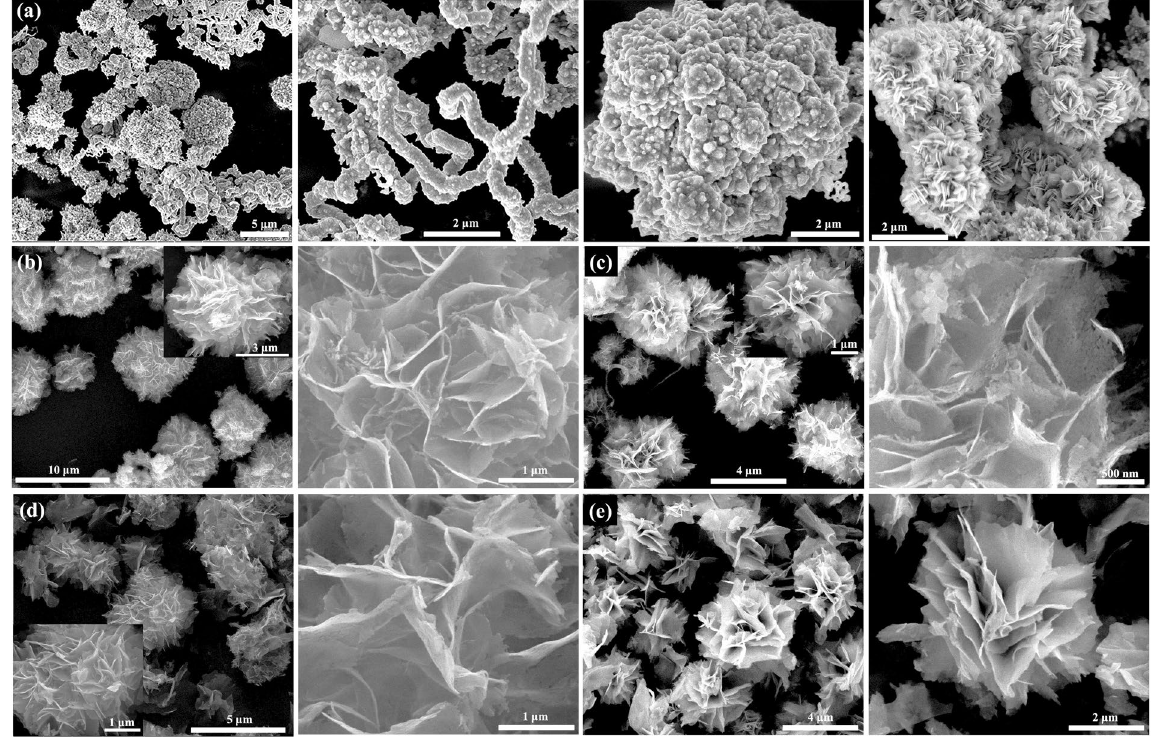
Figure 3. SEM images of as-prepared samples with different amount of Cd contents by keeping all other synthetic conditions fixed: ( a ) Cd-0, ( b ) Cd-0.5, ( c ) Cd-1, ( d ) Cd-2, and ( e ) Cd-4.